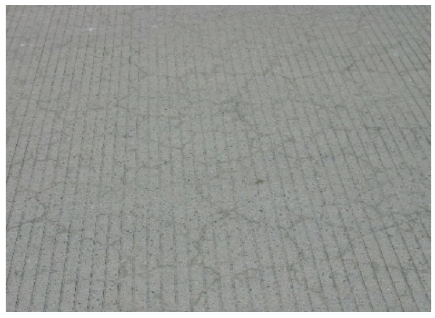
Figure 1: Map cracking (crazing) [12].